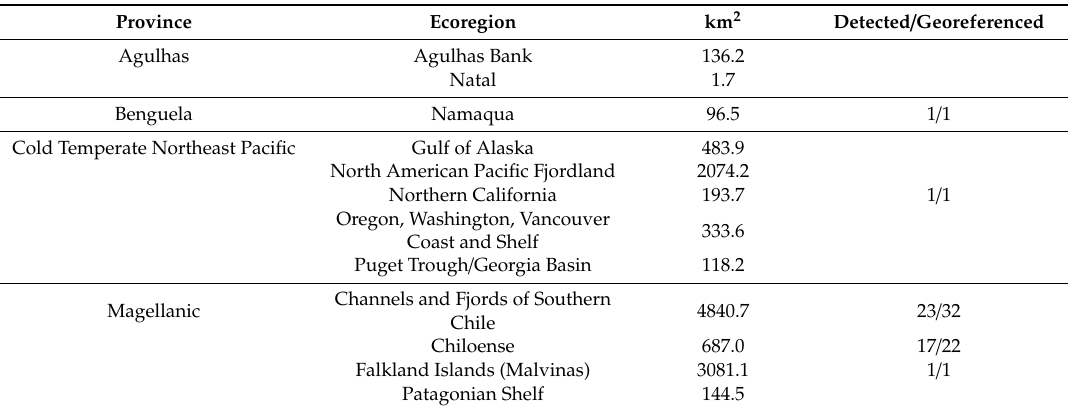
Table 7. Area in km 2 per marine ecoregion and province with detected giant kelp and intertidal green algae, and the number of detected grid cells versus the total of the georeferenced sites per ecoregion in a range of 300